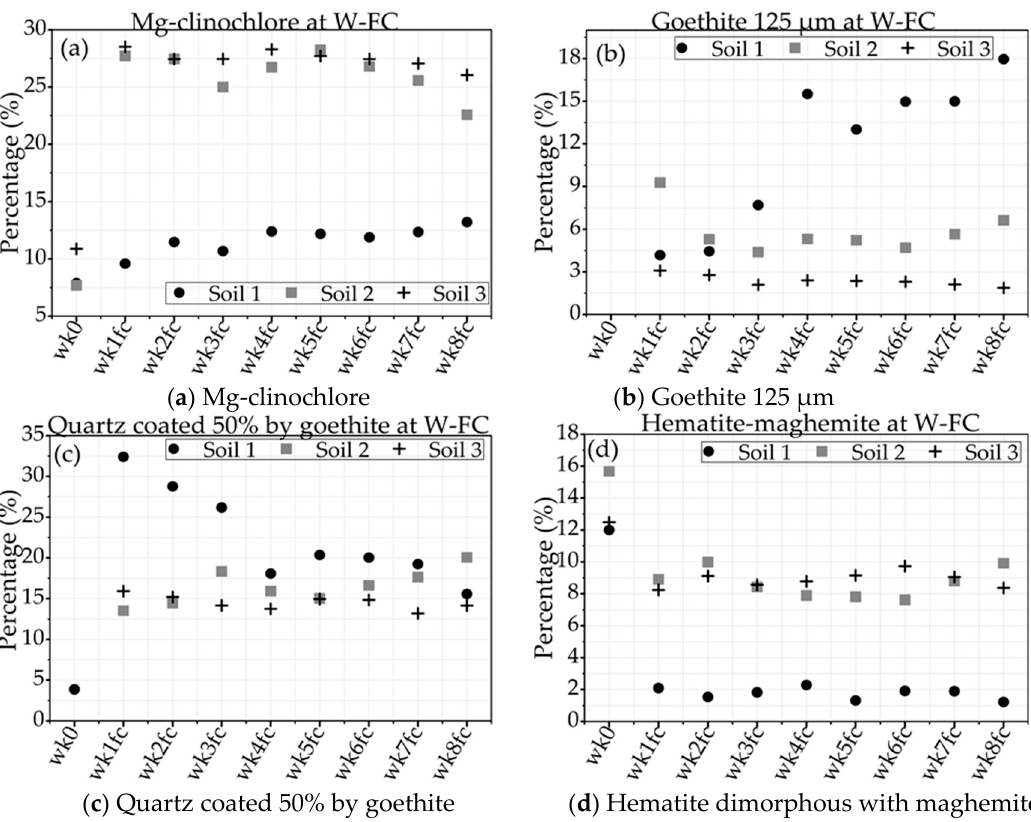
Figure 8. The average percentage of Mg-clinochlore ( a ), goethite 125 µm ( b ), quartz coated 50% by goethite ( c ) and hematite dimorphous with maghemite ( d ) changes for all the soils at the W-FC treatment. The circle, square and plus symbols represent Soil 1, Soil 2, and Soil 3, respectively. The vertical axis characterizes the percentage of each mineral occurring in an image. The scale of the Y-axis varies from 0% to 100%. In the horizontal axis, wk1fc,..., wk8fc stands for week 1fc, ..., week 8fc when the soil samples were at the field capacity conditions. There was no data available at the waterlogging conditions.